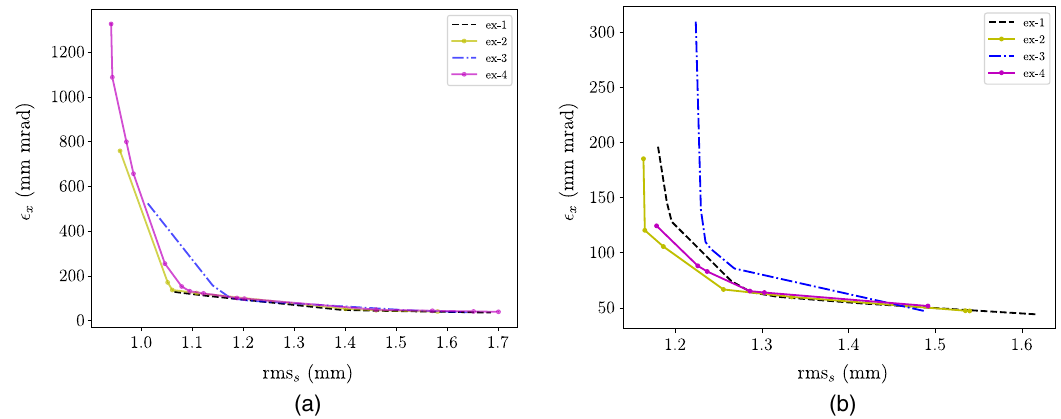
FIG. 8. Comparison of Pareto fronts for initial optimization experiments, ex-1 through ex-4. (a) Pareto fronts for ex-1 through ex-4 at s 1 , (b) Pareto fronts for ex-1 through ex-4 at s 2